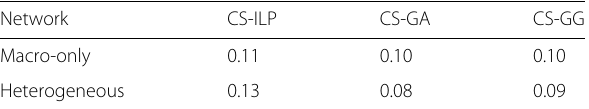
Table 4 Average percentage of muted resources